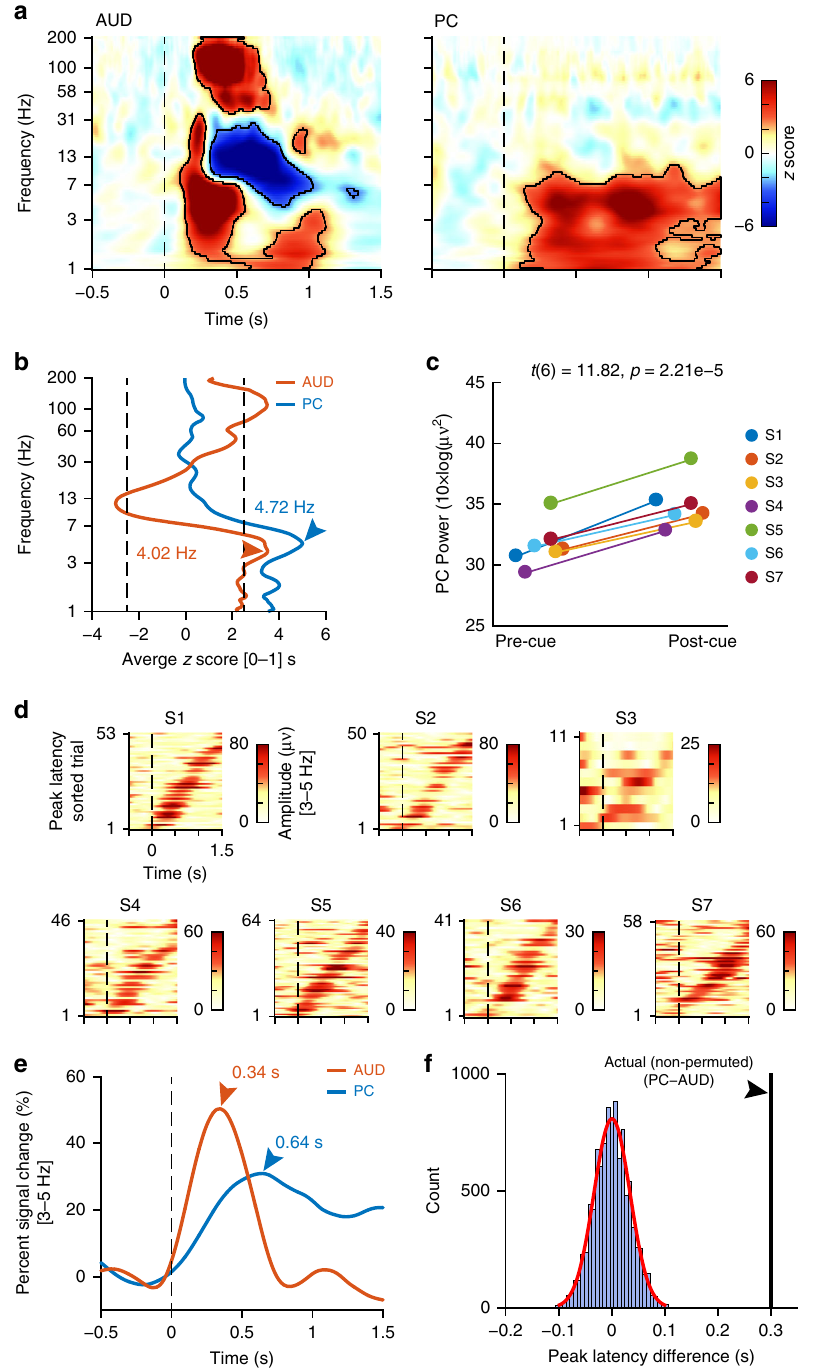
Fig. 2 Cue-induced local fi eld potential (LFP) amplitude changes. a Group-level auditory-cue-aligned spectrograms were computed from auditory cortex (AUD) and piriform cortex (PC) LFPs. Areas of statistical signi fi cance are outlined in black (false discovery rate (FDR) corrected p < 0.05, permutation test). b Frequency of maximal cue-evoked amplitude modulations in AUD (red) and PC (blue). The average z scores over a time window of [0 − 1] s following auditory cues are plotted as a function of the frequency. Arrows indicate peak frequencies. The vertical black dotted lines indicate the FDR- corrected threshold for statistical signi fi cance in a . c Individual-level analysis of auditory cue-induced responses in PC. Pre-cue and post-cue average low frequency (1 – 7 Hz) amplitudes are shown for each participant (S1 – S7). d Single-trial theta (3 – 5 Hz) amplitude time-series for each individual participant (S1 – S7). On each plot, trials are sorted by latency-to-peak. These plots show raw data that has not been baseline corrected. e Percentage of signal change at peak response frequency (3 – 5 Hz) in AUD (red) and PC (blue). Arrows indicate the time from auditory cue onset ( t = 0) to the peak response. f Peak latency difference between AUD and PC. The histogram (blue bars) indicates the null distribution of permuted differences between AUD and PC latencies. The red line indicates the normal curve fi t. The vertical black line represents the actual (non-permuted) peak latency difference (PC − AUD), revealing a statistically signi fi cant difference ( p < 0.0001, z = 8.81, permutation